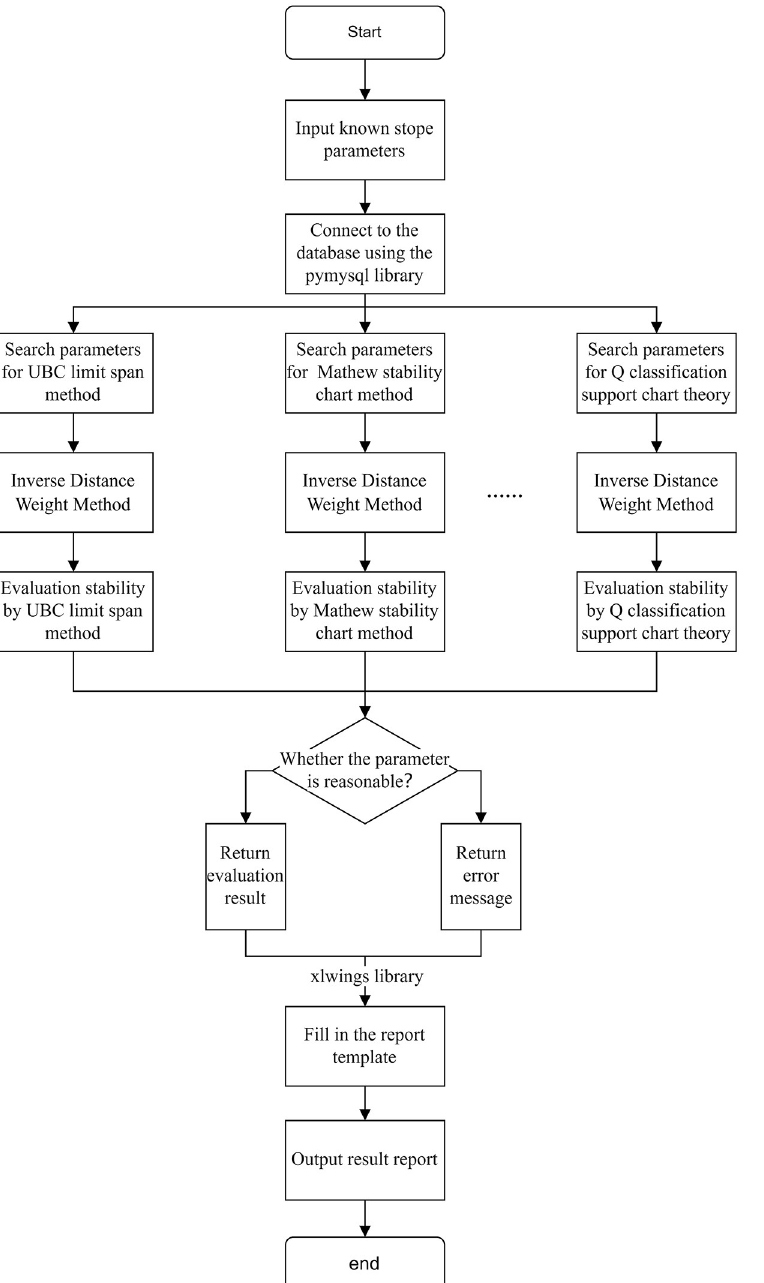
Fig 8. The algorithm flow chart of stope stability comprehensive evaluation